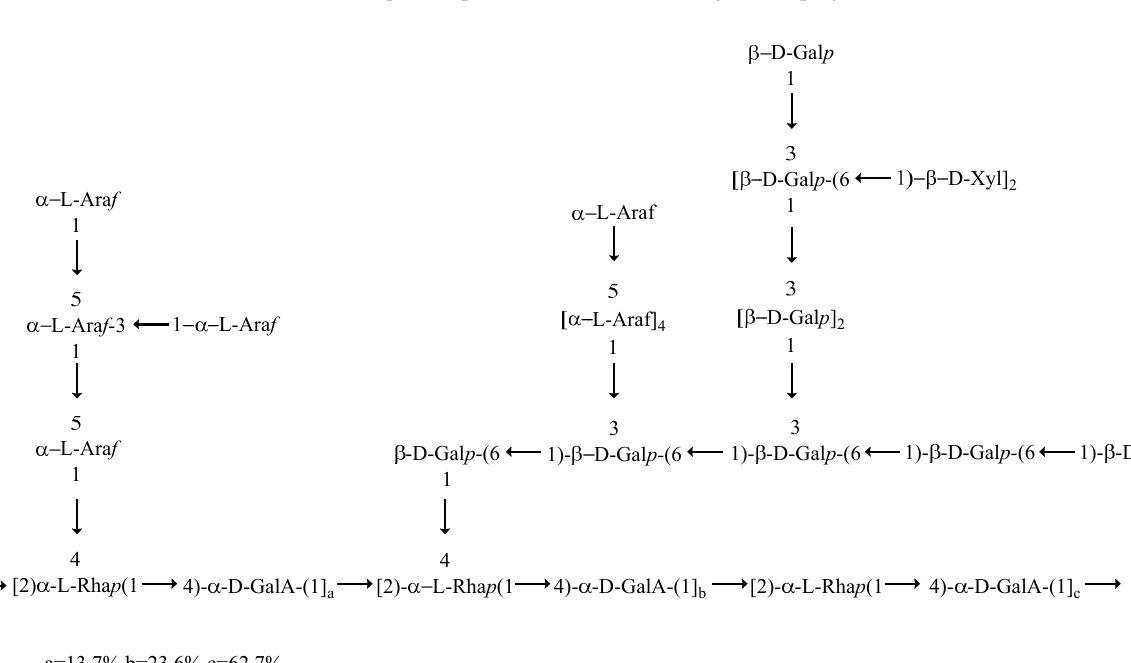
Figure 12. Model structure of LFP-1.